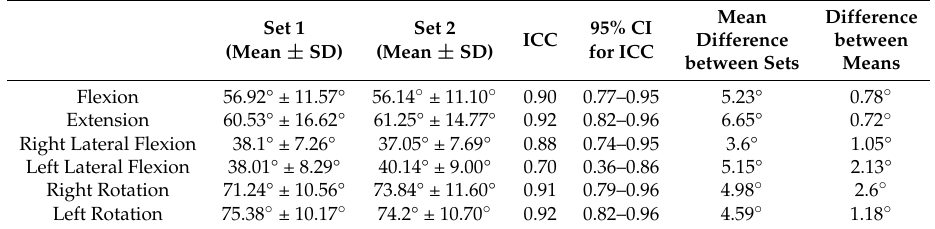
Table 2. Results for the two sets of motions performed with the second sensor located in T4 considering half movements.